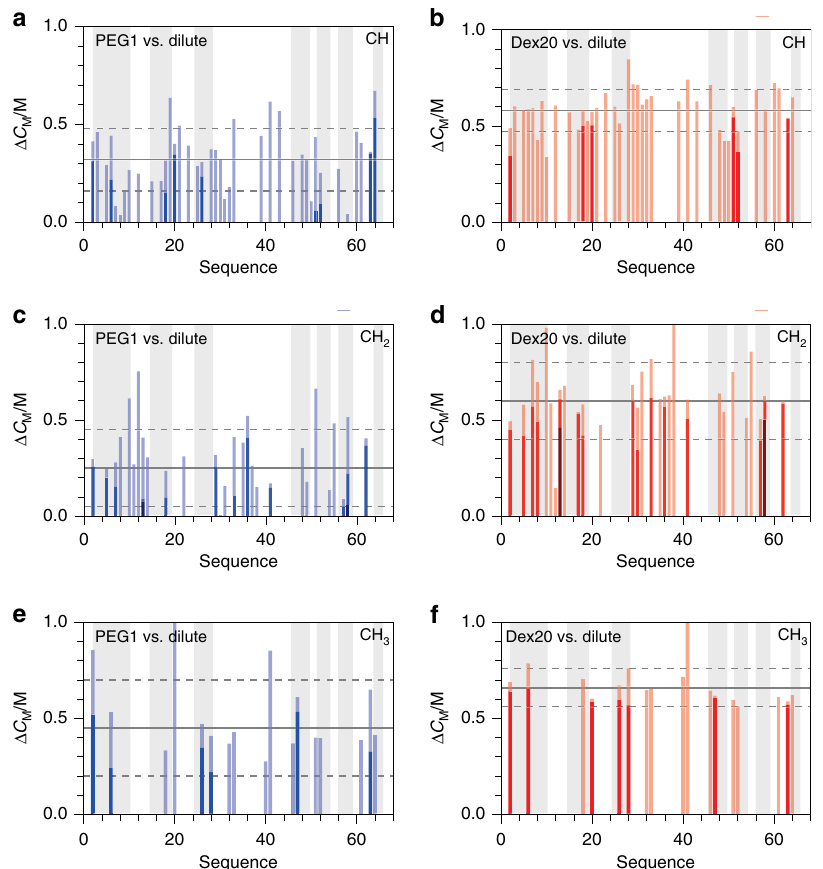
Fig. 3 Thermodynamic stability of main chain and side chain atoms comprising Bs CspB monitored via following folding-to-unfolding transitions induced by urea. a – f Difference in the transition midpoint, Δ C M , of CH protons ( a , b ), CH 2 protons ( c , d ), and CH 3 protons ( e , f ) observed in two- dimensional 1 H- 13 C HSQC NMR spectra comparing dilute conditions with the presence of c = 120 g/L PEG1 (colored in blue) or c = 120 g/L Dex20 (colored in red). Beta sheet regions according to PDB ID 1NMG are indicated by using a background colored in gray. The mean of Δ C M is shown by the horizontal line (continuous mode) whereas the mean plus or minus one standard deviation of Δ C M is represented by two additional horizontal lines (dotted mode). The presence of more than a single CH, CH 2 or CH 3 group per residue is highlighted by applying dark and bright mode of red or blue color, respectively. For the assignment of cross-peaks in two-dimensional 1 H- 13 C HSQC NMR spectra see Supplementary Fig.